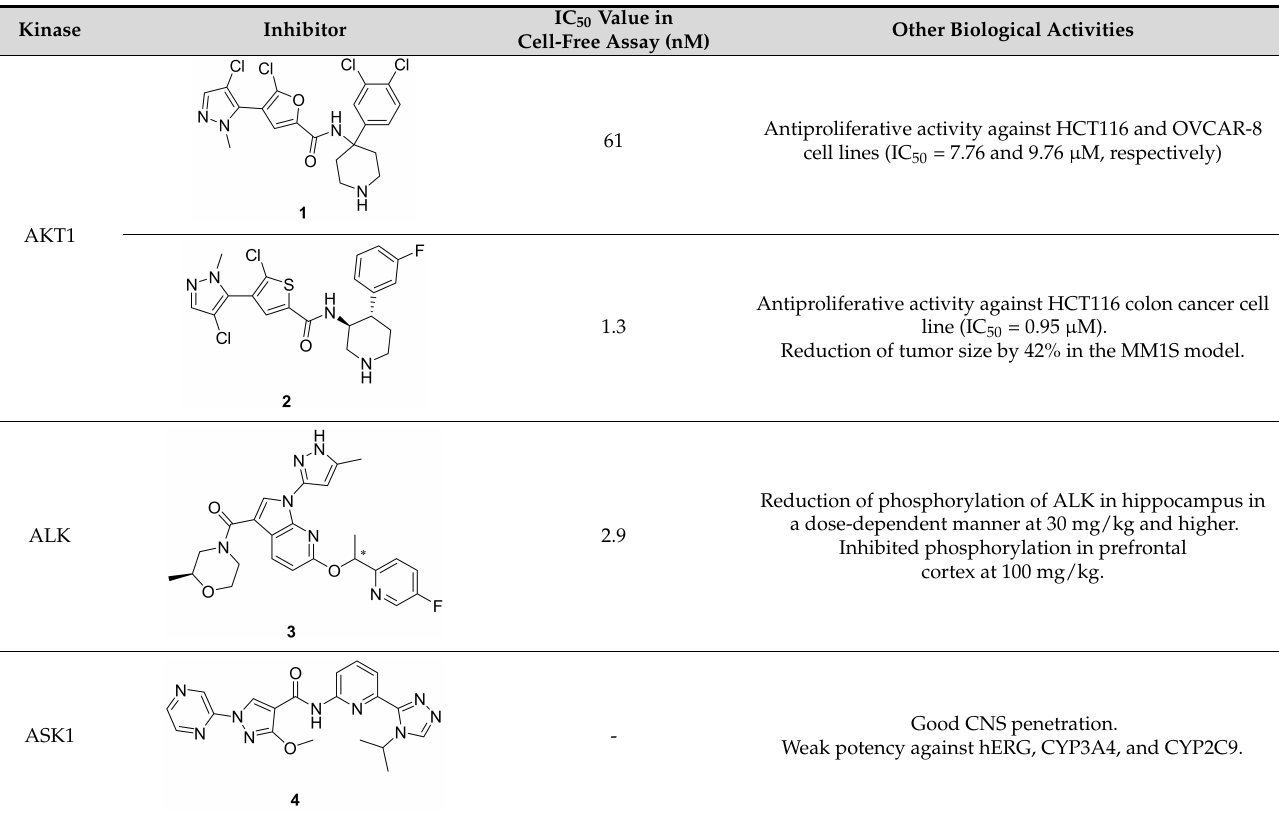
Table 1. Structures, IC 50 values, and the most important biological results of the reviewed pyrazole- based kinase